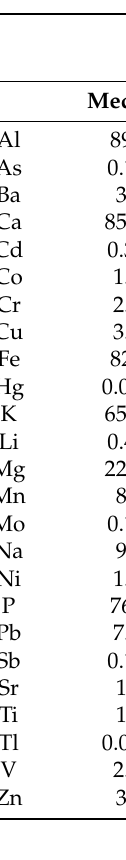
Table 2. Comparison of the results obtained in present study with two neighbouring countries and Norway, (in